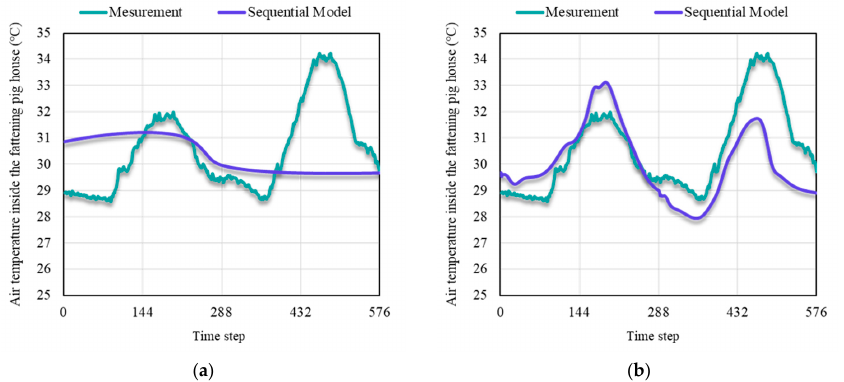
Figure 10. A comparative analysis of the predictive air temperature inside the fattening pig house according to the periodic parameter. ( a ) Learning without the periodic parameter. ( b ) Learning with the periodic parameter. Table 4. Validation of the RNN model for predicting the missing data, according to learning param- eters. Statistical Indices